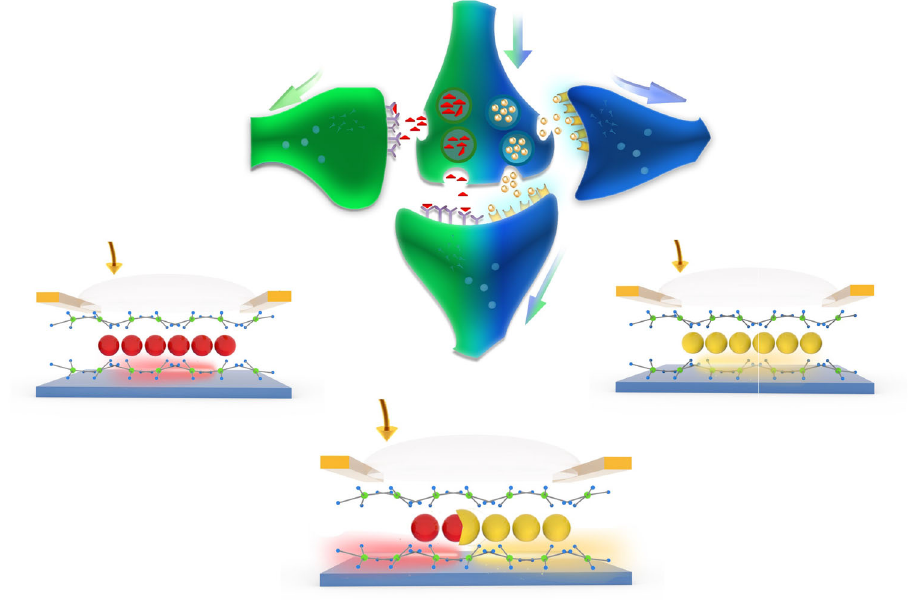
Fig. 1 Dual-excitatory PdSe 2 arti fi cial synapse. Schematic of biological synapse that can release two types of excitatory neurotransmitters, glutamate (red triangle), and dopamine (yellow circle), from a single presynaptic membrane; these neurotransmitters can interact with receptors on the postsynaptic membrane either independently or synergistically (top). Schematic of arti fi cial synaptic device based on layered PdSe 2 (bottom). When the device received negative presynaptic spikes, the hole (red sphere) accumulate in the conduction channel and the increasing hole currents simulate the postsynaptic glutamate currents (bottom left); when device received positive presynaptic spikes after negative spikes, the electrons (yellow sphere) began to neutralize holes, and the decreasing hole currents simulate the decreasing postsynaptic glutamate currents induced by inhibitory effect between glutamate and dopamine interaction (bottom middle); when the device continued to receive positive presynaptic spikes, the electrons accumulated in the conduction channel and the increasing electron currents simulated the postsynaptic dopamine currents (bottom the postsynaptic membrane, in which the two excitatory neurotransmitters work independently to induce long-term or short-term excitatory effects (Fig. 1, bottom left and bottom right devices), and synergistically to cause a reciprocal inhibitory effect (Fig. 1, bottom middle device). The postsynaptic response can be regulated over a wide range of characteristics by just tuning the polarity of the pulse that is applied to the input terminal, or the bias condition between the drain electrode and source electrode.